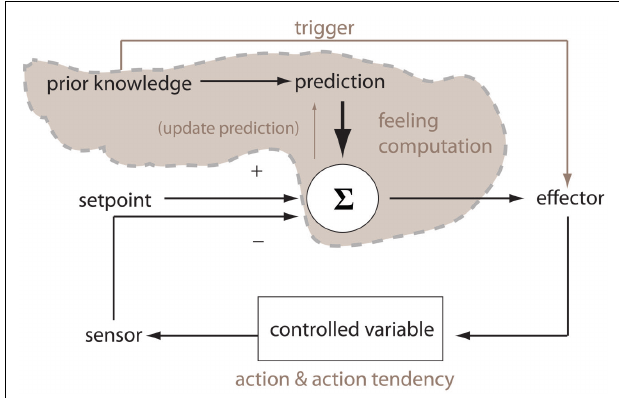
FIGURE 6 | Prediction–feedback control loop: adaptation of Sterling’s control theoretic perspective of allostasis. The additional feedback arrow relating to “update prediction” highlights our perspective on the relation between emotional feeling and action tendency. All labels and arrows in gray are additions to the original diagram of Sterling (2004).The primary emotional response concerns a prediction (emotional feeling) that may override homeostatic set points – make less sensitive to negative error – in order that metabolic resources may be recruited, e.g., in an emergency.The “effector” in this case amounts to parts of the brain, e.g., hypothalamus, brain-stem, that instigate somatovisceral changes preparatory to action.The “controlled variable” pertains to the metabolic resources that are aroused/galvanized.The (desensitized) “setpoint” determines whether sufficient resources are available for the particular action tendency (e.g., an active response based on approach or withdrawal). At such a point a secondary emotional response ensues (regulation, cf. Koole, 2009) where up- or down-regulation of the action tendency occurs and prediction may be updated. For example, negative feedback would lead to down-regulation of emotional response and the prediction schema being updated such that set points are not so desensitized in the future.This, however, may also be overridden by higher (contextual) levels of processing.This control loop diagram can be mapped onto the Damasio neural-anatomy diagram in Figure 4